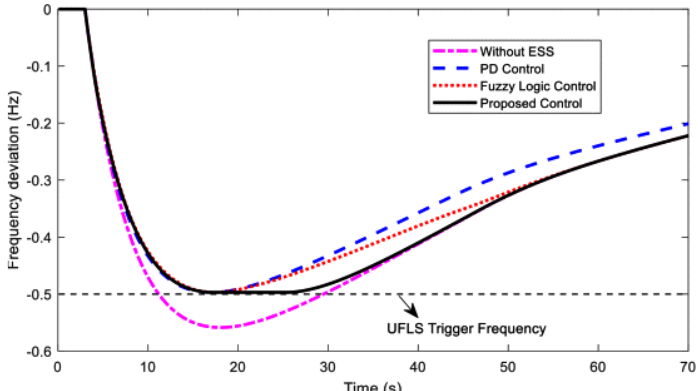
Figure 24. Frequency deviation with and without